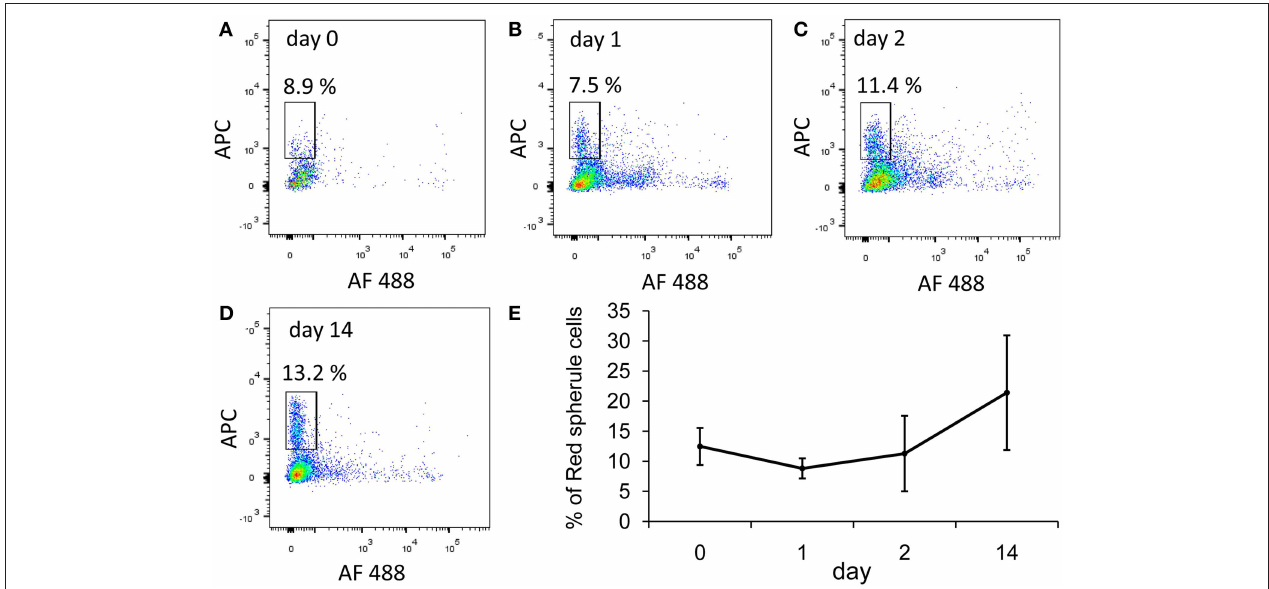
FIGURE 3 | The percentages of red spherule cells in the purple sea urchin coelomic fluid does not change in response to Vibrio challenge. Three adult sea urchins were injected with the heat-killed marine bacterial species, Vibrio diazotrophicus . Coelomic fluid was collected before injection (day 0) and post injection at days 1, 2, and 14. Cells were labeled with propidium iodine to exclude dead cells. Red spherule cells were gated by their far red auto-fluorescence (APC channel). (A–D) Percentages of live red spherule cells from animal #1 at all time points (within the rectangular gate) in the coelomic fluid over 14 days post challenge. (E) Percentages of red spherule cells in the total live coelomocyte population of the three animals tested. Differences in the red spherule cell percentages over time were not significant by Anova two factor analysis. Standard deviation is indicated by vertical bars.